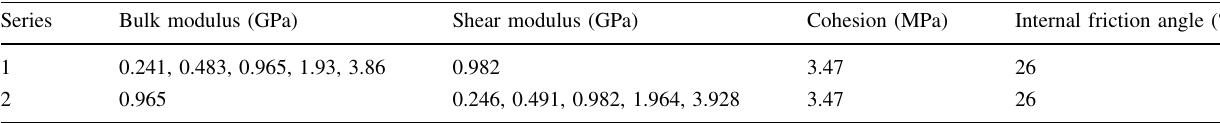
Table 3 Determined parameters for numerical simulation